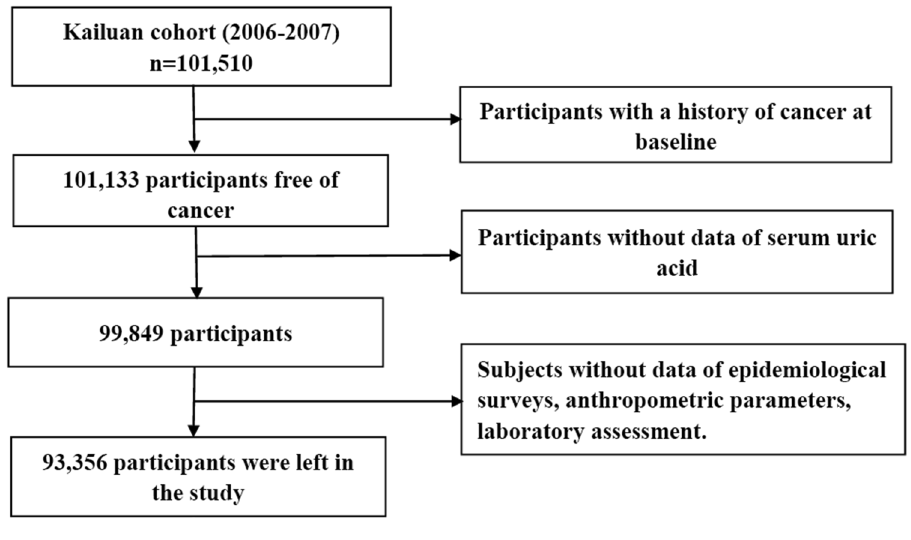
Figure 1. Flow chart of study